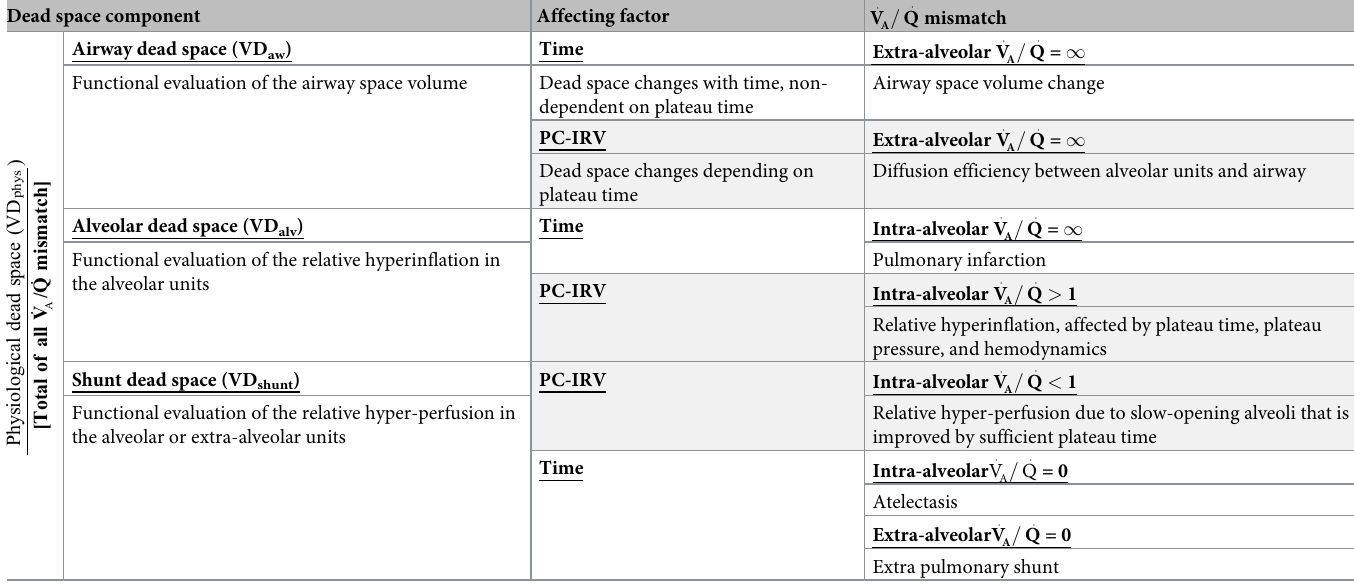
Table 1. Interpretation of dead space components. Dead space component